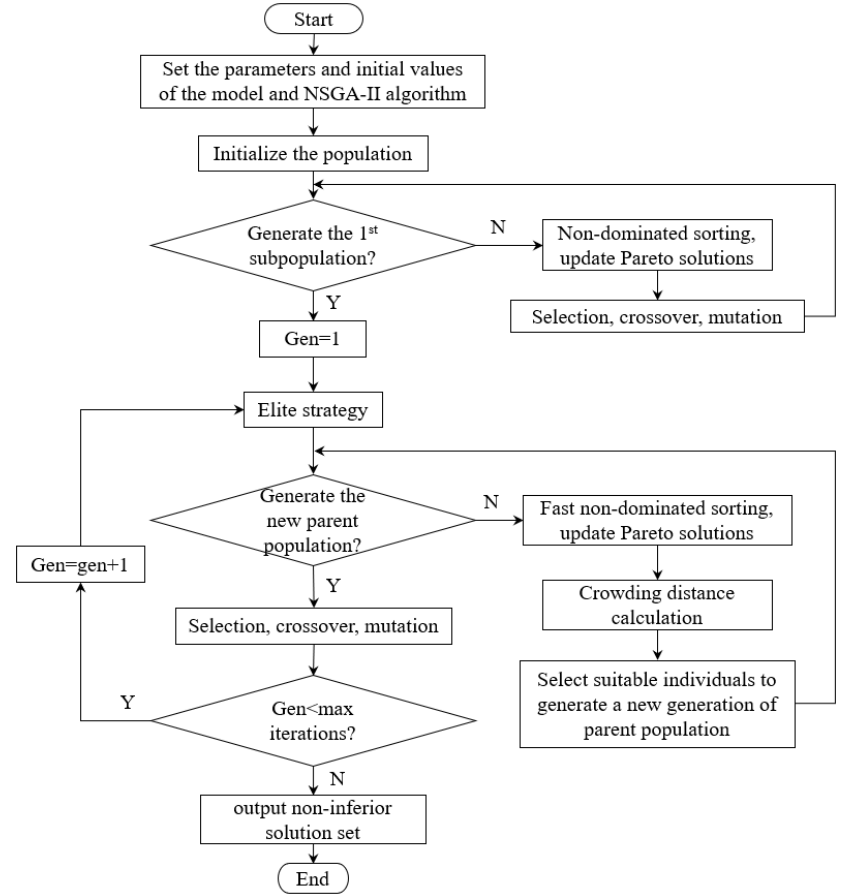
Figure 4. Steps of NSGA-II.